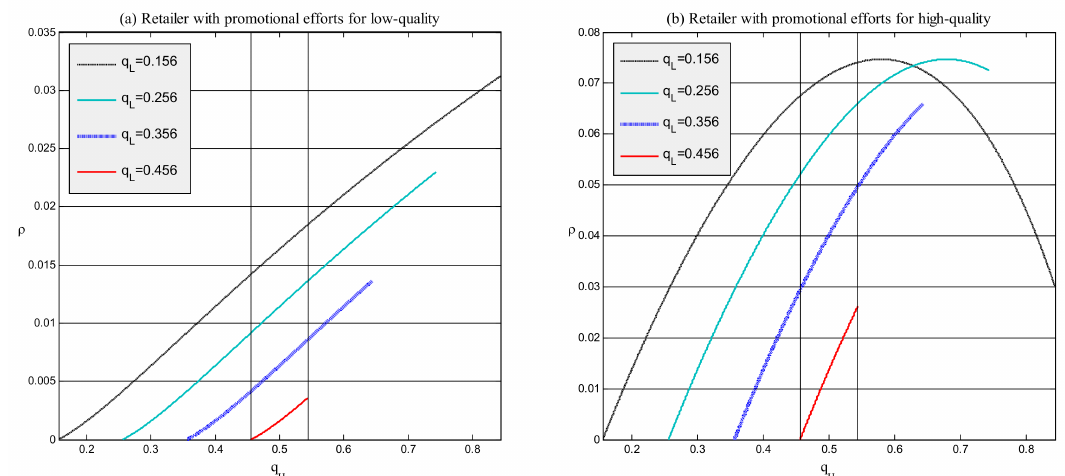
Figure 9. Sensitivity analysis for the retailer’s promotional